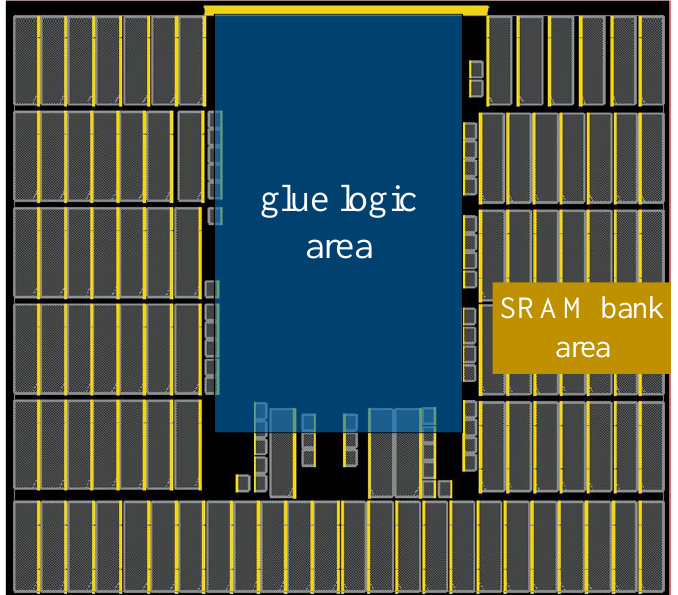
Figure 5. SRAM compilation and placement in traditional methodology. Table 1. DMem bank performances under different configurations.